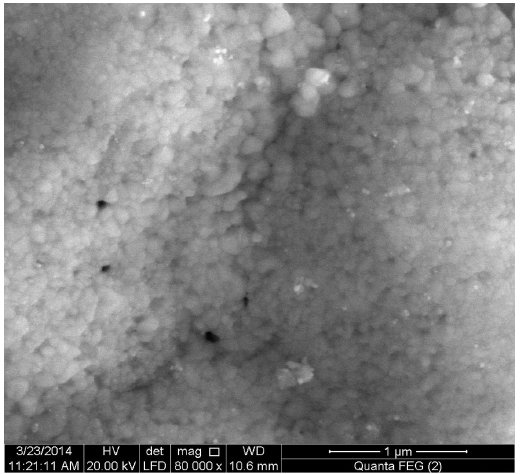
surfaces were confirmed by